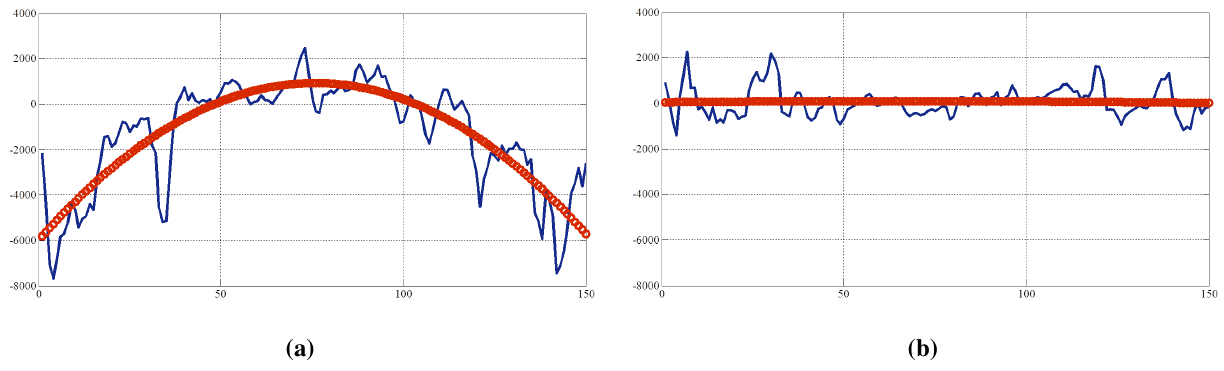
Figure 9. Cumulative sums of the differences (DiF) of ( a ) a real face and ( b ) a fake face. However, these distributions are not appropriate to be used for liveness detection without any refinement. The existence of noise affects the results. Therefore, curve fitting is performed to extract meaningful features. The sum of the DiF of real faces has a similar shape to the curvature of a quadratic equation, y = ax 2 + bx + c . In the quadratic equation, there are three coefficients, A = and these are exploited as a feature for classification. To calculate the values of these coefficients,